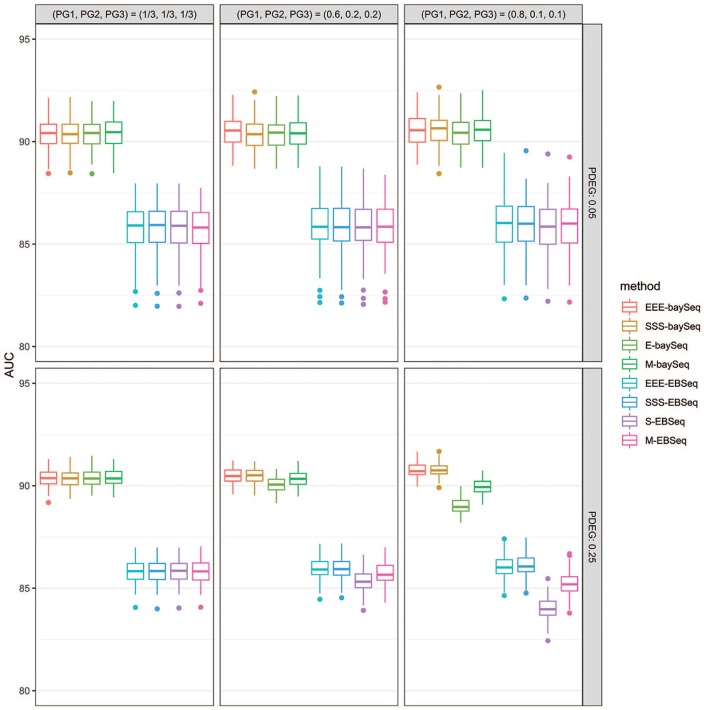
Boxplots of AUC values for simulation data
(Nrep = 3).Abbreviation: AUC, area under the ROC curve. Representative boxplots for
AUC values under three conditions, (1/3, 1/3, 1/3), (0.6, 0.2, 0.2), and
(0.8, 0.1, 0.1), are shown. The average AUC values in the plots are
shown in Table
1.